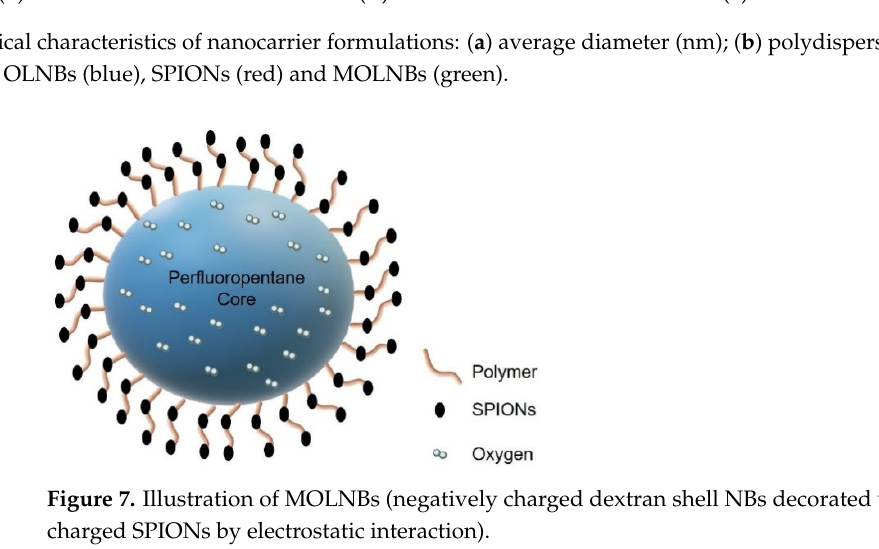
Figure 8. HAADF-STEM images of the MOLNBs decorated with SPIONs taken at different magnifications ( a = 500 nm, b = 200 nm, c = 20 nm).